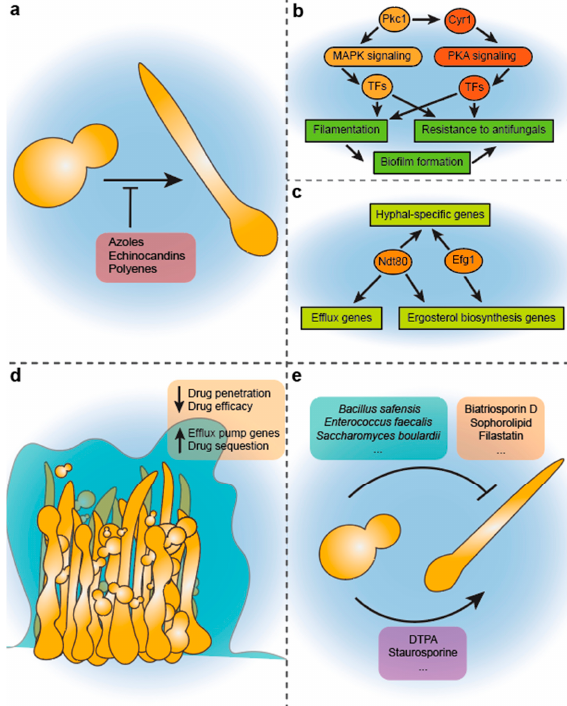
Figure 1. Linking morphogenesis with antifungal drug treatment and drug resistance in Candida . ( a ) antifungals and their impact on morphogenesis. Candida morphogenesis can be blocked with treatment with antifungal compounds, including azoles, echinocandins, and polyenes [161,162,165–167]. This morphogenetic inhibition is seen even at sub-inhibitory concentrations of all three classes. ( b ) interactions between signalling pathways that govern morphogenesis and drug resistance. The protein kinase C (PKC)-MAPK pathway and the cAMP-PKA pathway are both involved in drug resistance and morphogenesis in Candida . Depicted are the downstream effects of PKC which regulates MAPK signalling to maintain cell wall integrity when exposed to drugs. Pkc1 has been found to regulate Cyr1 [171], which is a part of the cAMP-PKA signalling pathway, which governs filamentous growth [39]. Pkc1 is implicated in regulation of both drug resistance [172] and hyphal formation [171]. Signaling from the PKA pathway also plays a role in drug resistance via Cyr1 signaling [173,174], as well as morphogenesis [39]. Downstream transcriptional regulators of both MAPK and PKA pathways ultimately regulate morphogenesis and resistance to antifungals. Morphogenesis and filamentous growth also contribute to biofilm formation, which in turn enhances antifungal resistance. ( c ) transcriptional regulation of antifungal drug resistance and morphogenesis. Transcription factors such as Efg1 and Ndt80 have previously been linked to modulating expression of hyphal specific genes and promoting filamentation [95–97,175,176]. Both of these transcriptional regulators are also involved in drug resistance, via regulation of genes involved in drug efflux and/or ergosterol biosynthesis [176–180]; ( d ) coupling Candida morphogenesis and drug resistance through biofilm formation. Biofilms of polymorphic Candida species are typically composed of diverse cellular morphologies: hyphae, pseudohyphae and yeast [38]. Once established, these polymorphic biofilms secrete an extracellular matrix (ECM) that helps shield Candida from the external environment. Biofilms play a significant role in antifungal drug resistance by preventing antifungal penetration, sequestering antifungals, upregulating antifungal drug efflux, and metabolic regulation that limits antifungal activity [105,181–183]; ( e ) novel compounds for targeting Candida morphogenesis. New compounds are being discovered that can modulate filamentation in Candida species, and may serve as novel therapeutic strategies for treating fungal infections. Examples include drugs (i.e., filastatin), and compounds secreted by competing microbes (i.e., Bacillus safensis ) that prevent filamentation, and drugs that enhances filamentation (i.e., diethylenetriaminepentaacetic acid